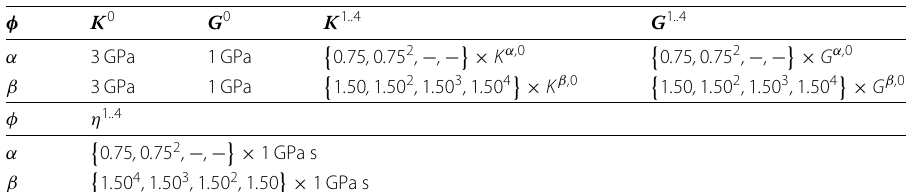
Table4 Two phases, curved interface: Material